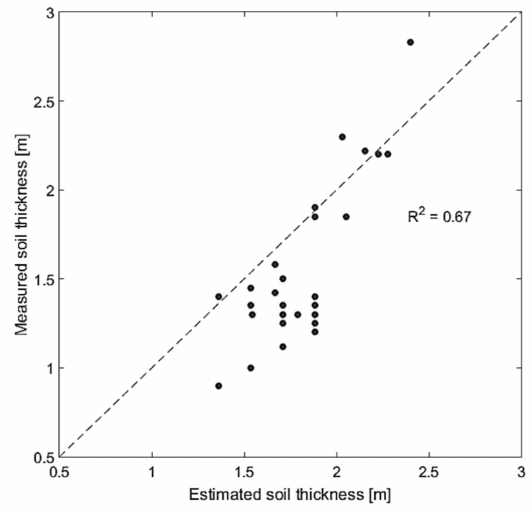
Figure 6. Measured vs. estimated soil thickness points.